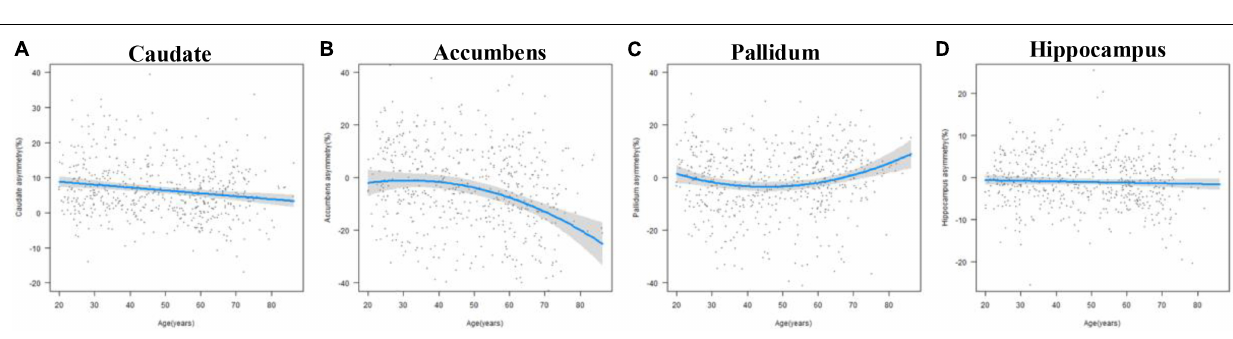
FIGURE 2 | The age trajectories of left (upper layer graph) and right (lower layer graph) subcortical volumes, including the (A) caudate, (B) putamen, (C) accumbens, (D) pallidum, (E) thalamus, (F) hippocampus, and (G) amygdala.